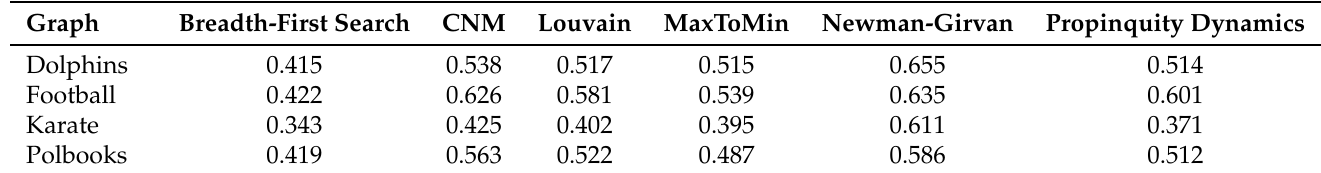
Table 5. Modularity.